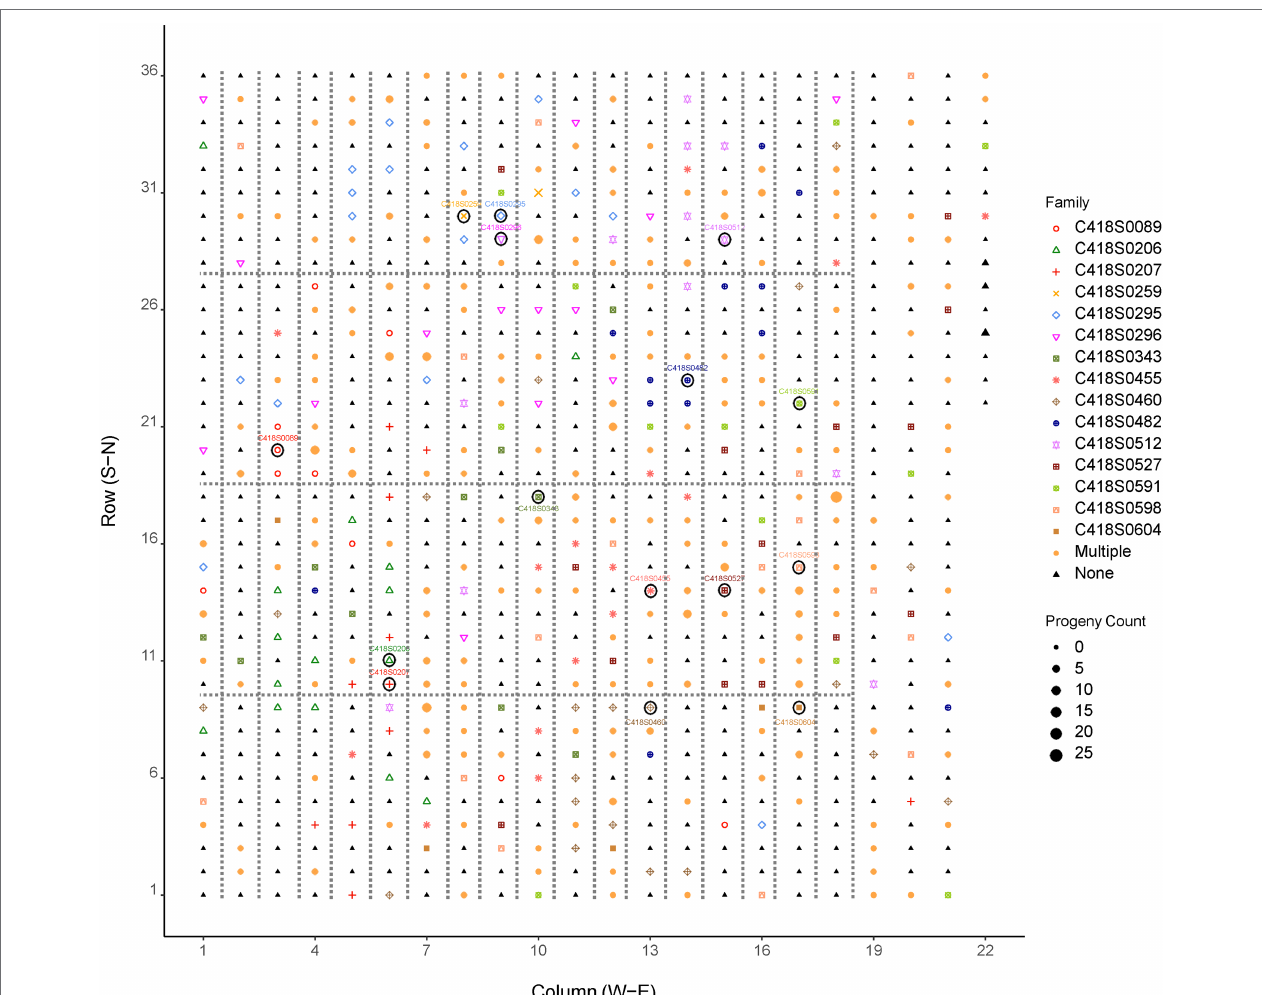
FIGURE 2 | Distribution of pollen donors in the cycle 4 IWG breeding population (UMN_C4) at the University of Minnesota. Symbols enclosed within a circle are mother plants. The position of fathers in the breeding nursery are indicated by shapes and colors of the family/mother plant. Larger shapes indicate more progeny fathered by a given genotype. Fathers of more than one progeny are represented by the shape and color labeled as “Multiple.” “None” indicates plants that were not identified as fathers of the mother plants and their progeny sampled for this study. Plants enclosed within dotted lines are half-sibs; plants not enclosed within the dotted lines are F 1 genets obtained from bi-parental